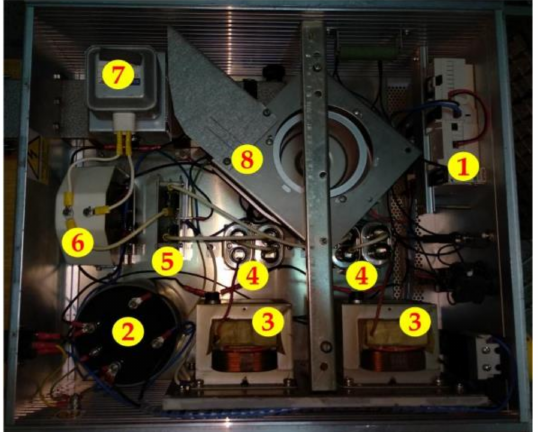
Figure 6. Internal arrangement of a microwave power